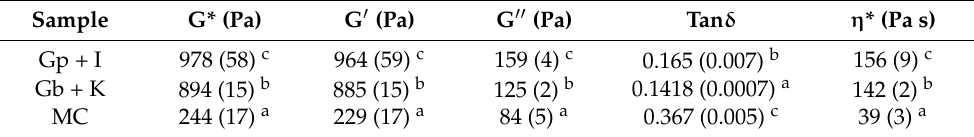
Table 2. Rheological parameters of gels (Gp + I: porcine gelatin plus iota carrageenan; Gb + K: bovine gelatin plus kappa carrageenan; MC: methylcellulose). Sample G* (Pa) G (cid:48) (Pa) G (cid:48)(cid:48) (Pa) Tan